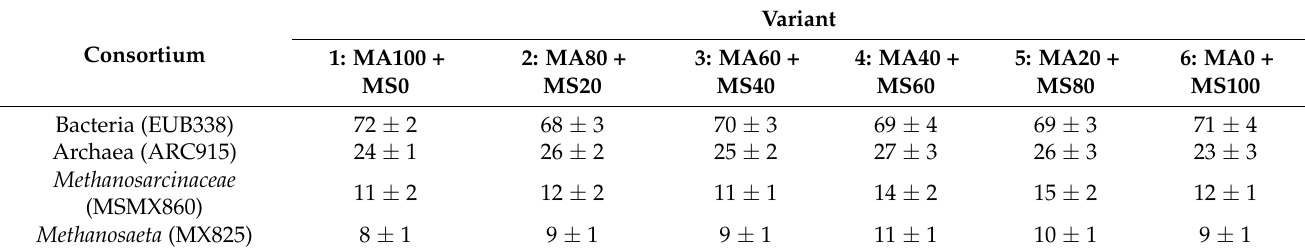
Table 4. Microbial taxonomy in AS across experimental